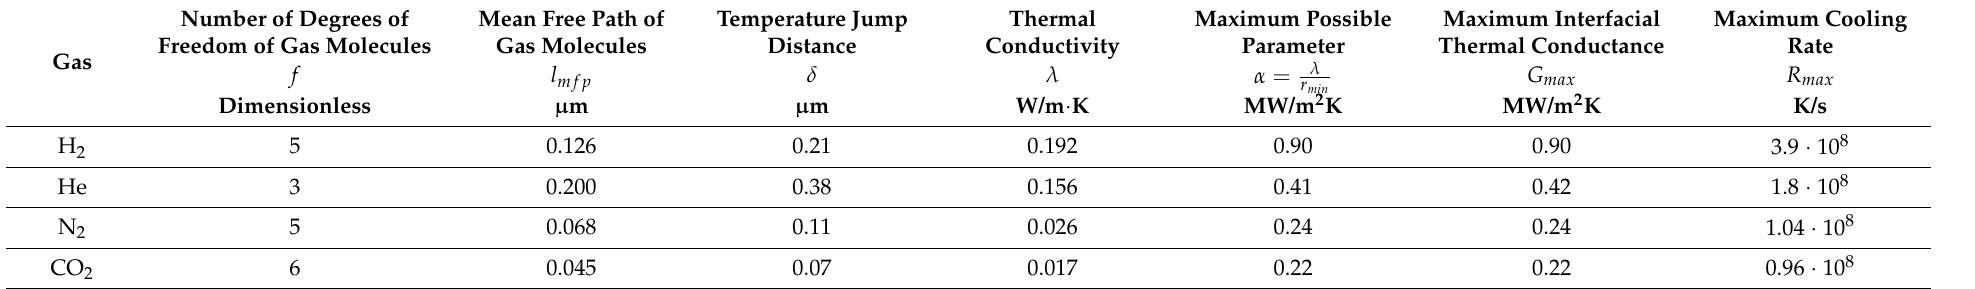
Table 1. Thermal and contact parameters of gases for a blackened membrane at 300 K and 10 5 Pa.